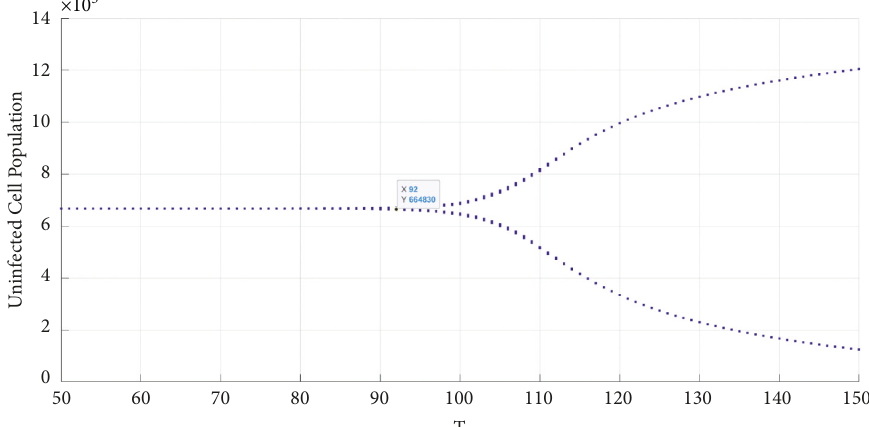
Figure 8: Bifurcation behavior for time delay with respect to uninfected cell